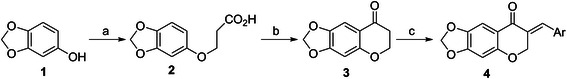
Synthesis of [1,3]dioxolo[4,5-
g
]chromen-8-ones 4. (a) NaOH, Na2CO3, Br(CH2)2COOH, H2O, reflux, (b) oxalyl chloride, SnCl4, benzene, (c) aromatic aldehydes, HCl (g), 0°C.